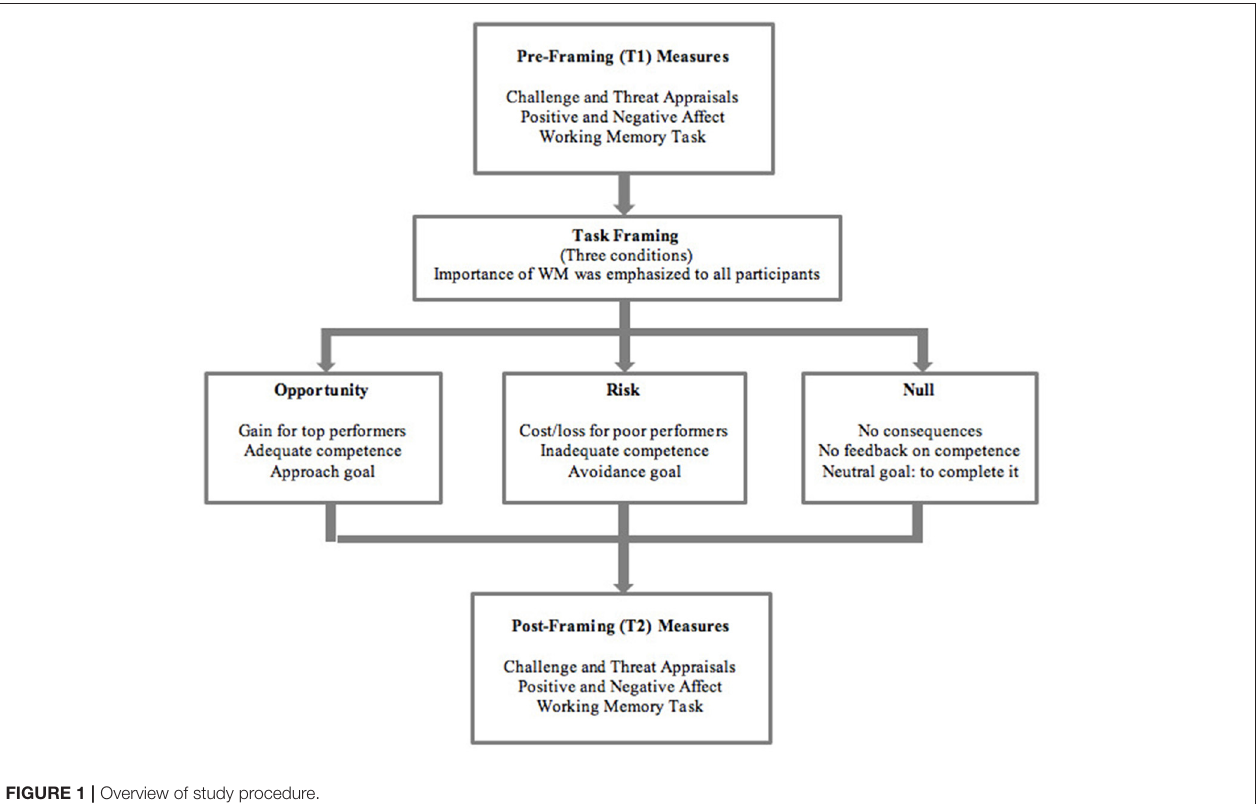
FIGURE 1 | Overview of study procedure.